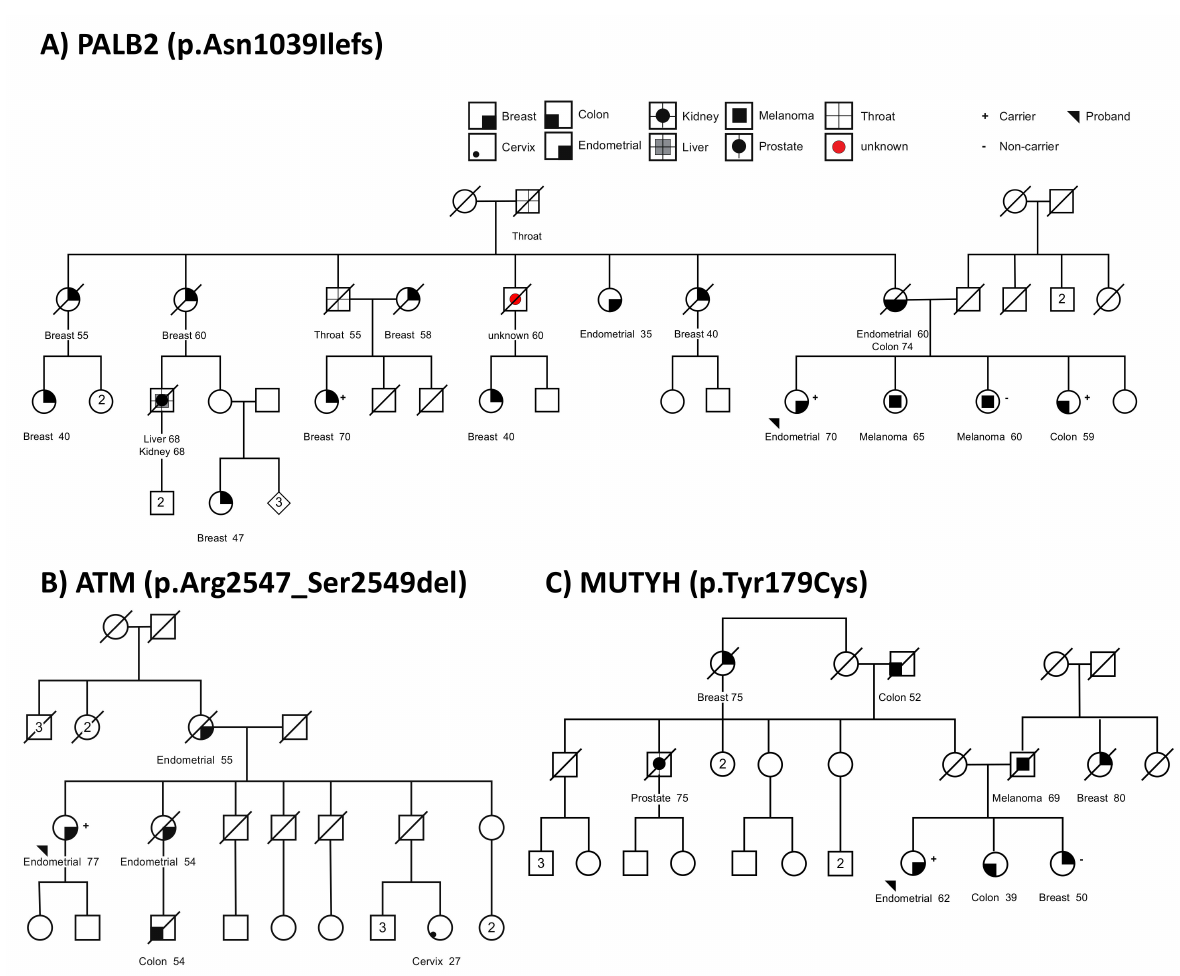
Figure 2. Pedigrees of families of the endometrial cancer cases carrying candidate variants. ( A ) Family pedigree of PALB2 p.Asn1039Ilefs carrier. ( B ) Family pedigree of ATM p.Arg2547_Ser2549del carrier. ( C ) Family pedigree of the endometrial cancer case carrying candidate MUTYH p.Tyr179Cys. Squares symbolize males, circles symbolize females. Affected individuals are indicated by highlighted symbols, with cancer type and age at diagnosis noted below. Unaffected individuals are indicated by empty symbols. Endometrial cancer proband sequenced is indicated by black arrow below the symbol. Variant carriers are indicated by a (+) symbol and the non-carriers are indicated by a ( − )